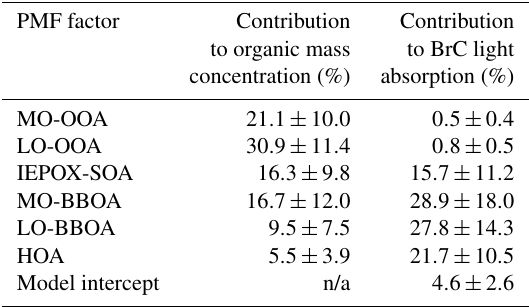
Table 4. Contribution of PM 1 components as represented by the PMF factors to organic mass concentrations and BrC light absorp- tion. The contribution of the model intercept to BrC light absorp- tion is also included. Values listed are resulting means and standard deviations of the contributions calculated throughout IOP2. Small differences between the values in the second column and the val- ues represented in the inset of Fig. 5a are due to differences in data coverage by the aethalometer and AMS.